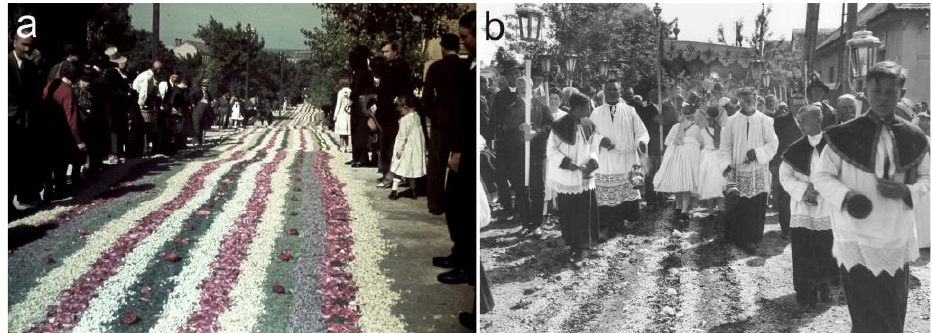
Figure 6. Flower carpet for the procession of Corpus Christi in Budaörs, Hungary ( a ) 1940; by unknown photographer; ( b ) 1943; photograph by Carl Lutz; donated by Archiv für Zeitgeschichte ETH Zürich/Agnes Hirschi. Courtesy of Fortepan).